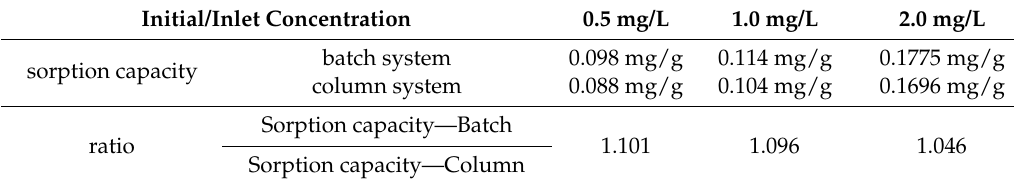
Table 6. The comparison of sorption capacity obtained from the batch system and column system.